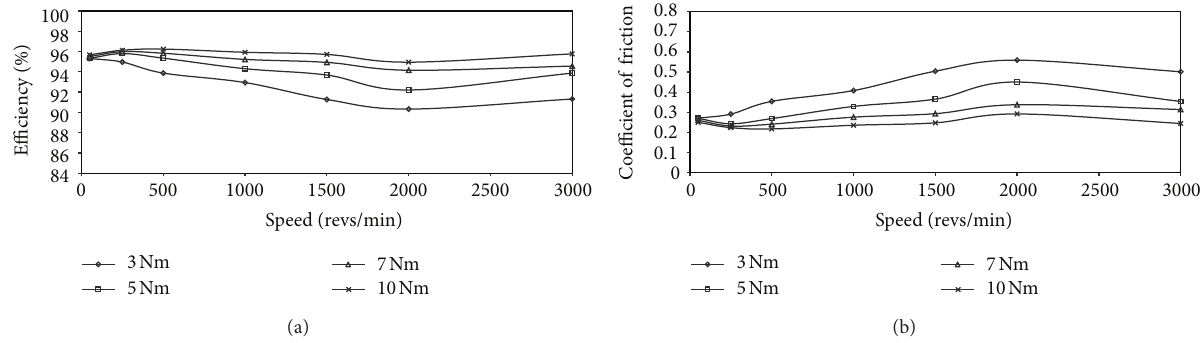
F 7: Showing (a) the efficiency and (b) the derived coefficients of friction for 20